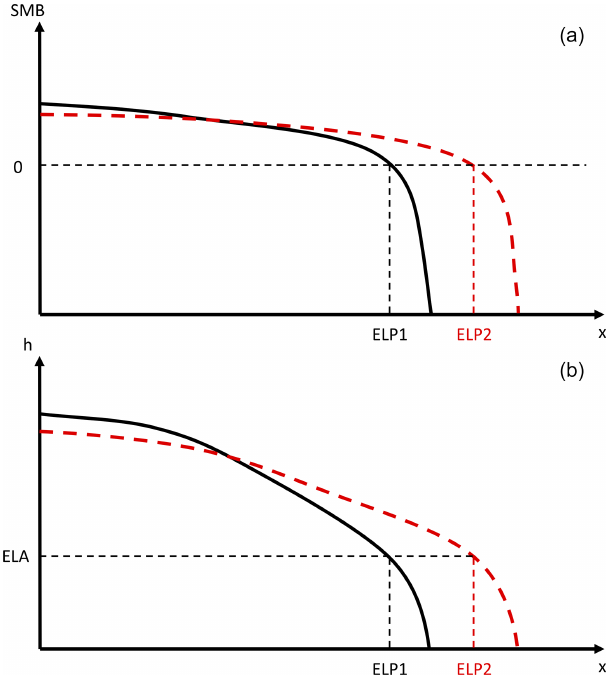
Figure 1. (b) Schematic cross section for two different ice sheet geometries and (a) associated surface mass balance. The two ge- ometries share the same equilibrium line altitude (ELA) but exhibit different horizontal equilibrium line positions (ELP1,